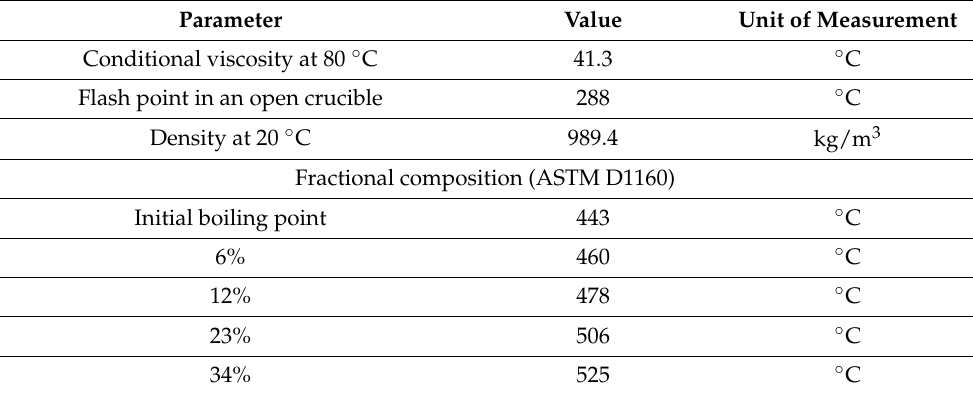
Table 6. Parameters of